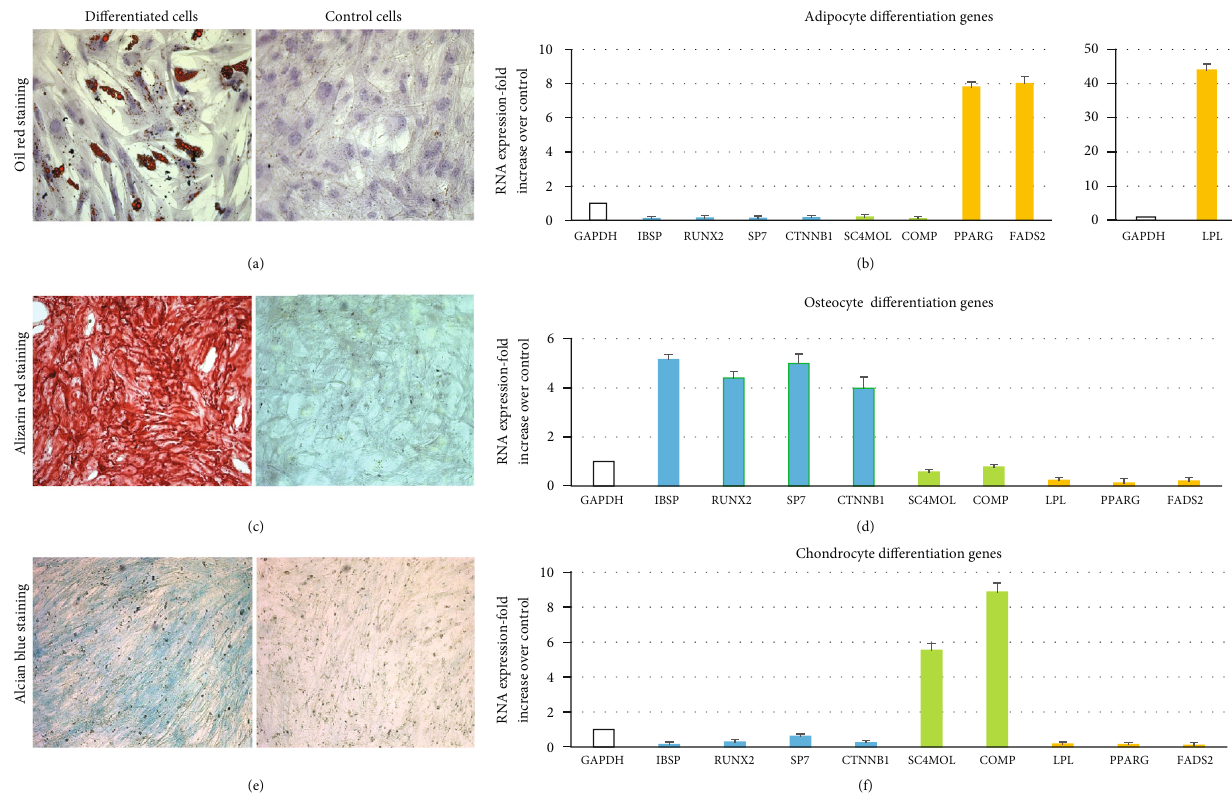
Figure 7: Di ff erentiation of MSC isolated from non-enzyme-treated SVF. Light microscopic images are representative of three separate experiments. (a) Adipocyte di ff erentiation. (c) Osteocyte di ff erentiation. (e) Chondrocyte di ff erentiation. (b, d, f) Semiquantitative qRT-PCR analysis showing lineage-speci fi c gene